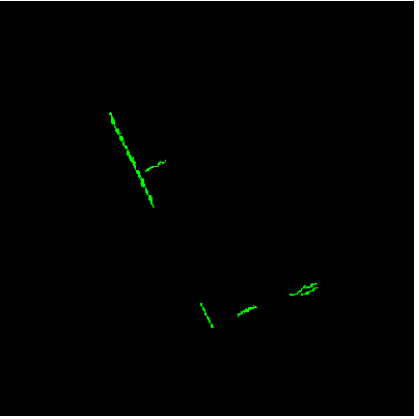
Figure 7. A. Main shadows extracted using closing operation followed by elimination of unrelated connected components, B. Borders of shadows